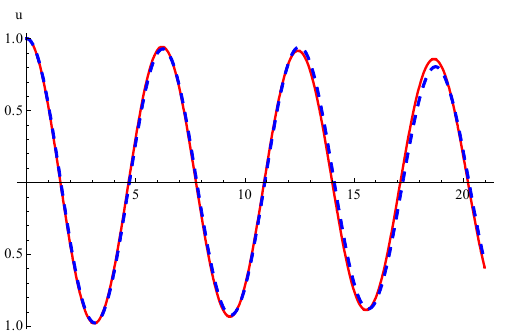
Figure 4. Comparison between the numerical solution of Equations (10) and (23) at internal resonance and approximate solution (60) : ____ numerical integration solution; _ _ _ analytical solution..